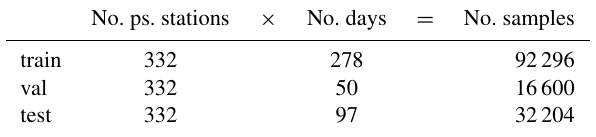
Table 1. Number of pseudo-stations and number of samples for the training (train), validation (val) and testing (test) data sets. No. ps. stations